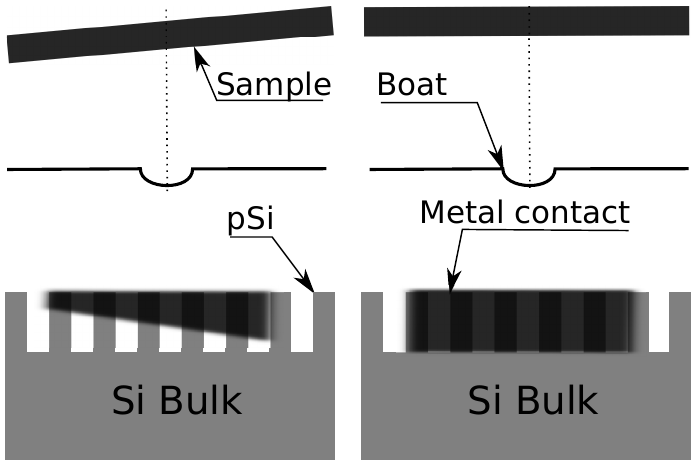
Figure 10. ( Left ) The sample is placed obliquely to the normal of the evaporation boat. ( Right ) The sample is placed at a normal with respect to the boat. The normal is shown as a dashed line. The resulting contact geometries are shown in the lower figures. Although both figures have similar features, the annotations have been placed on only one side of each for clarity. For details, see Section